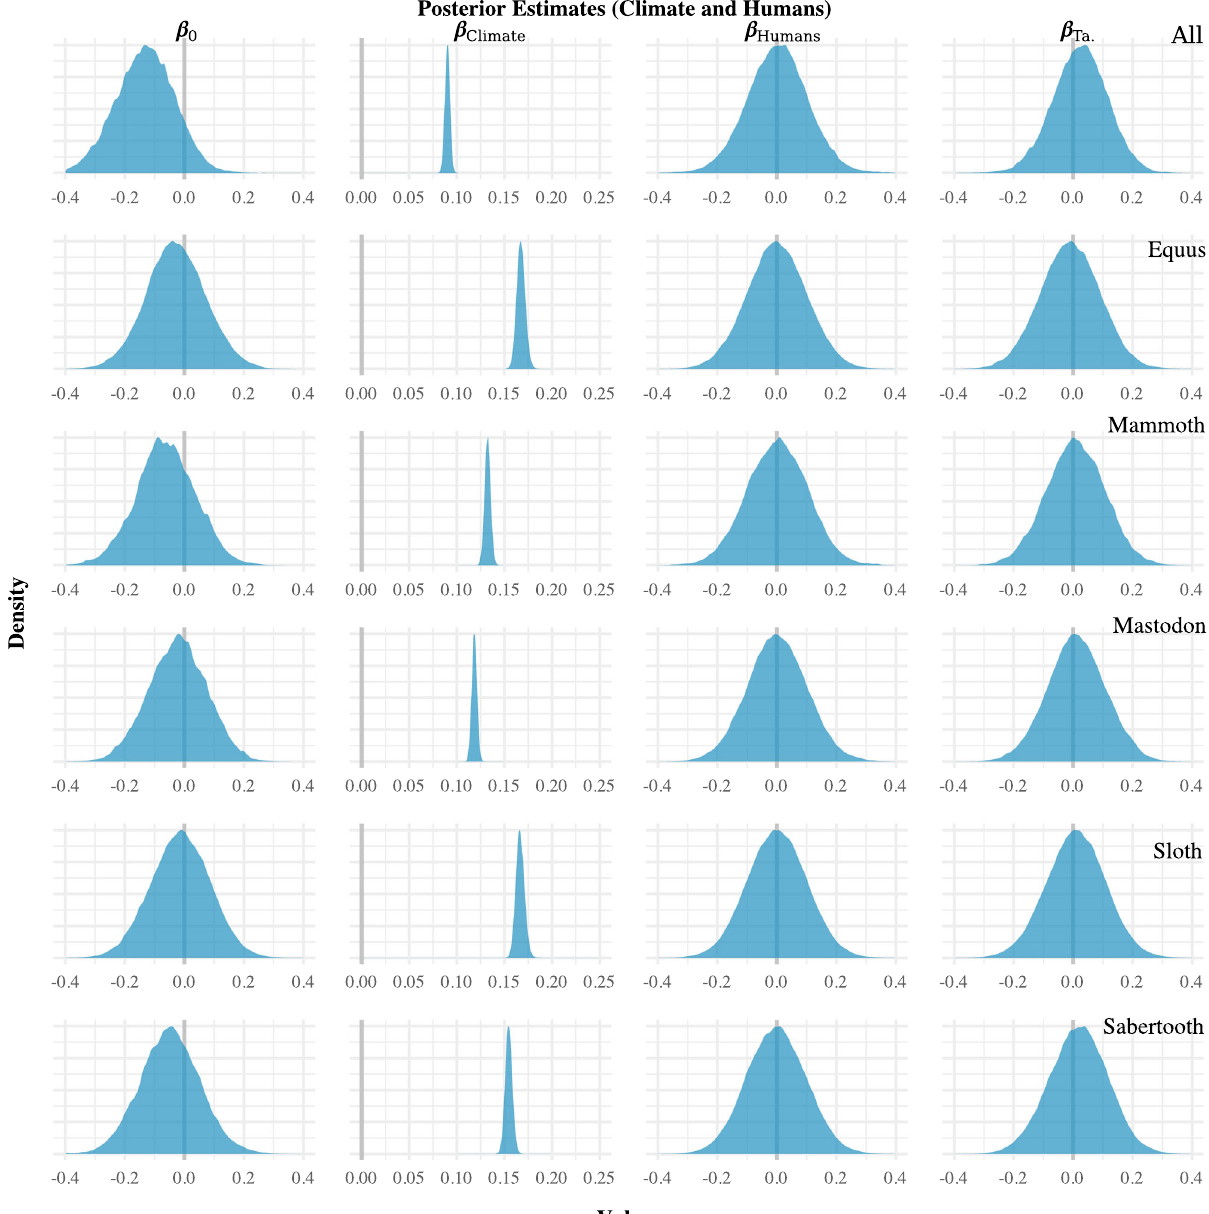
Fig. 6 Regression results of the extended climate analysis. Consistent with our earlier fi ndings, the climate ( β Climate ) estimates do not overlap zero (denoted by the vertical grey lines), whereas the human ( β Human ) estimates centre on